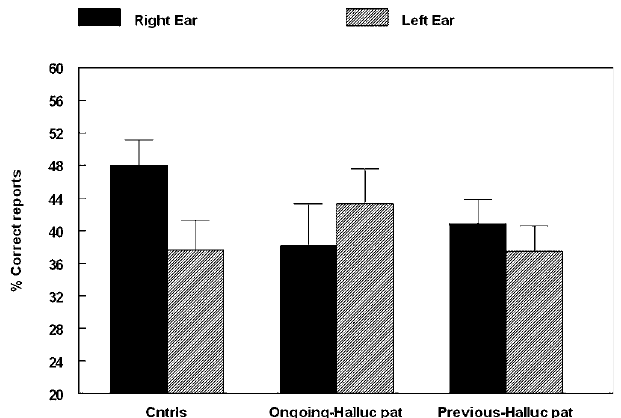
Figure 2. Percent correct reports on the CV-syllables DL paradigm split for right and left ear stimulus presentations, and healthy controls, non- hallucinating and hallucinating patients with schizophrenia.